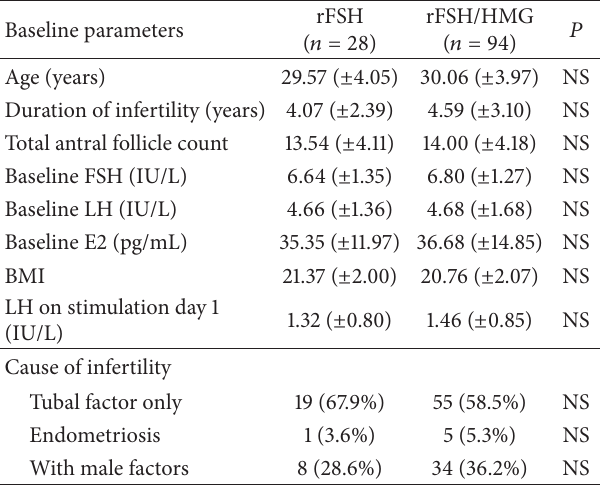
Table 1: Patient population baseline